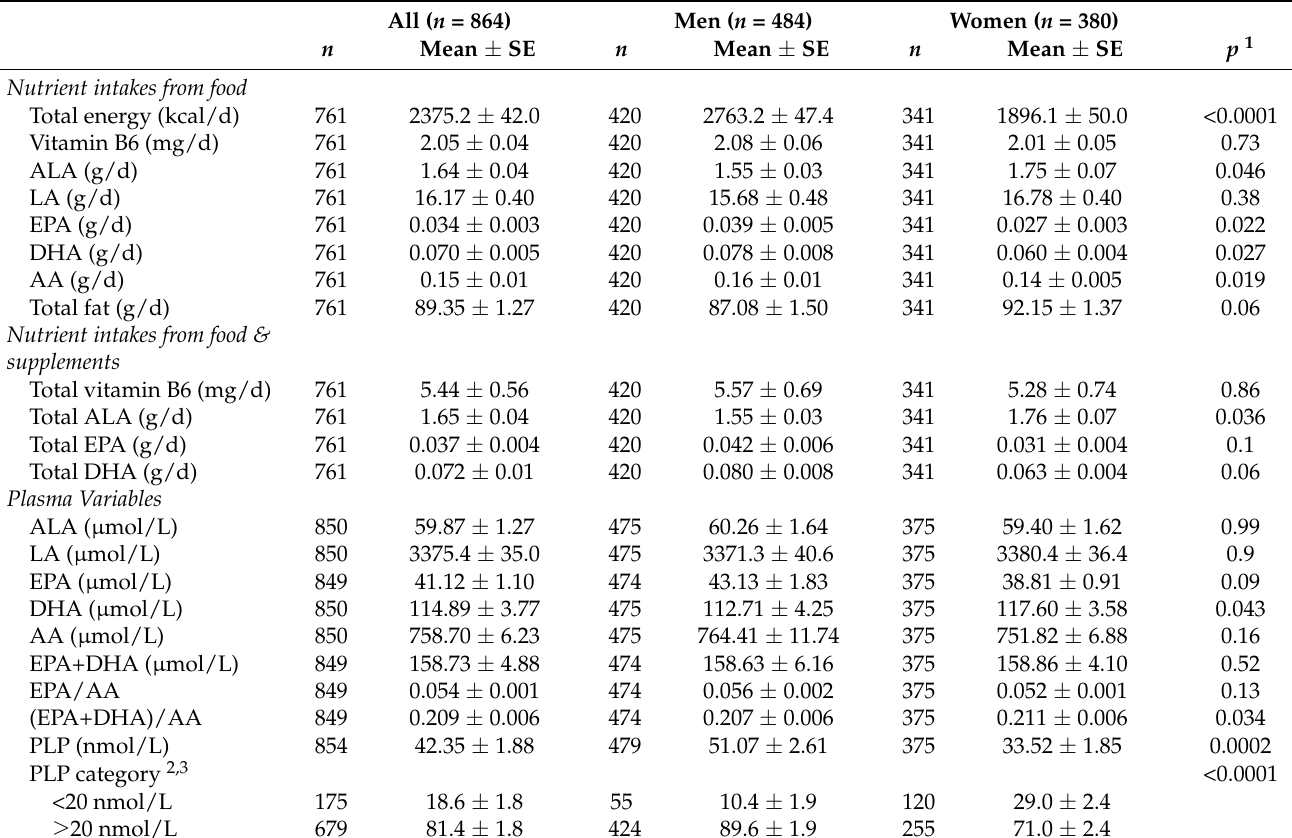
Table 2. Distributions of the energy-adjusted intakes of vitamin B6 and PUFA and the plasma concentrations of PUFA and pyridoxal 5 (cid:48) -phosphate (PLP) by gender among US adults aged 20–59 years, NHANES